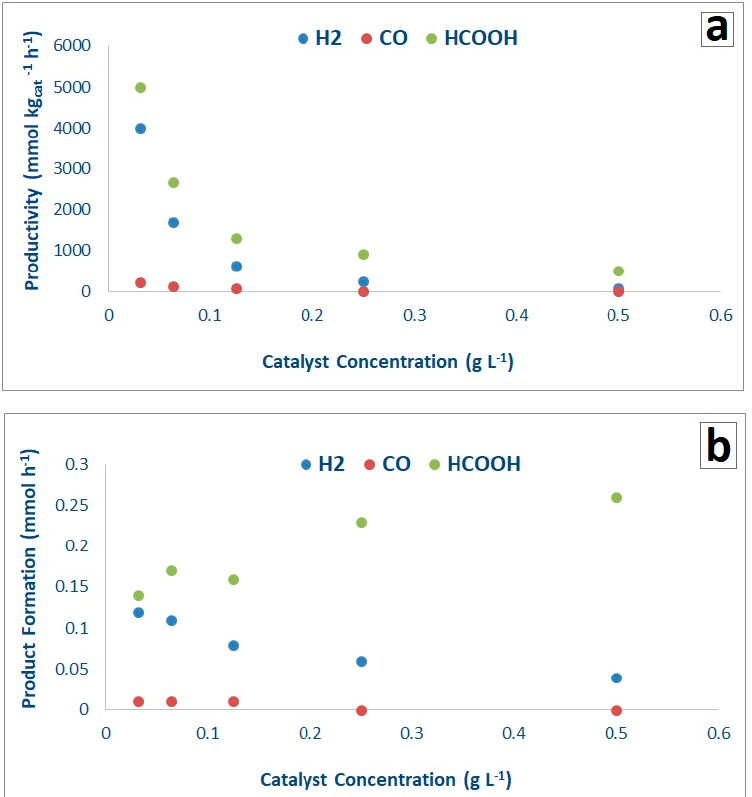
Figure 6. Effect of catalyst concentration on productivity ( a ) and absolute product formation ( b ) with the P25 as a catalyst (1.66 g L − 1 HS and at pH = 13/14).